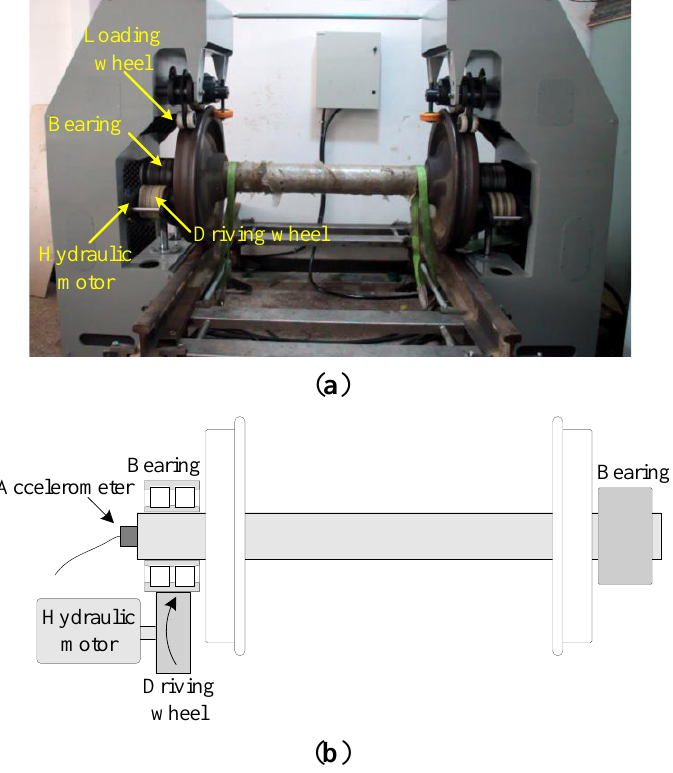
Figure 11. ( a ) The arrangement of the locomotive bearing test bench; ( b ) Schematic view.